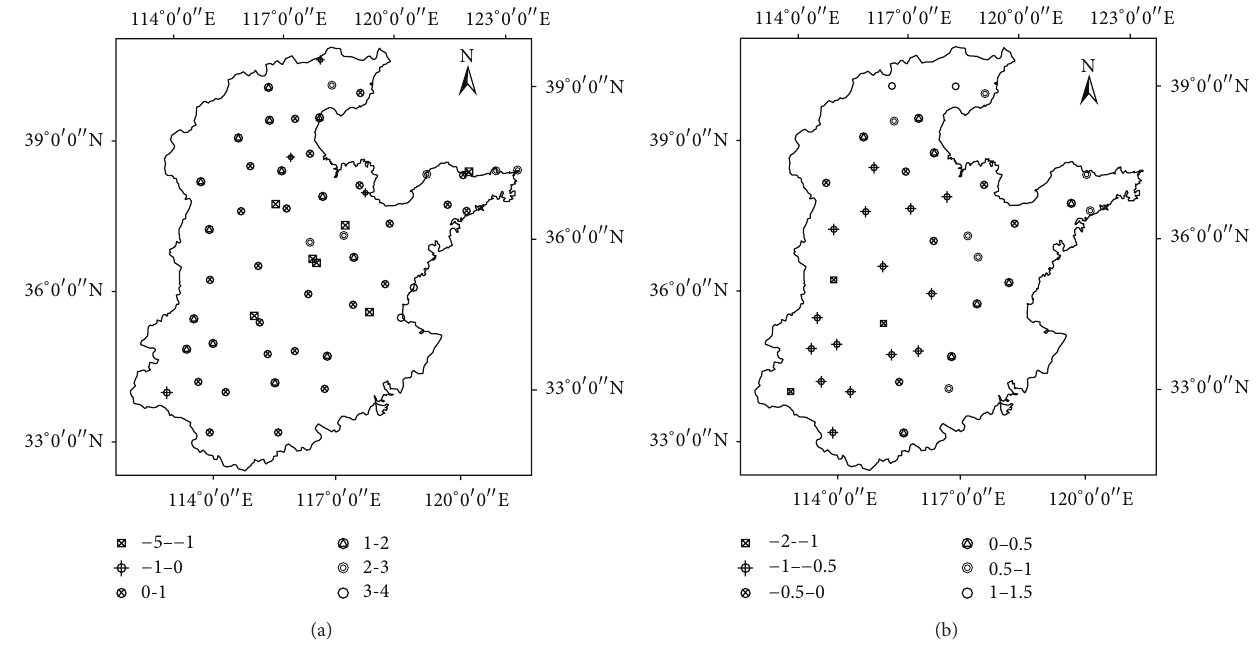
Figure 6: Difference between the observed and simulated daily average temperature in the North China Plain in February and August.